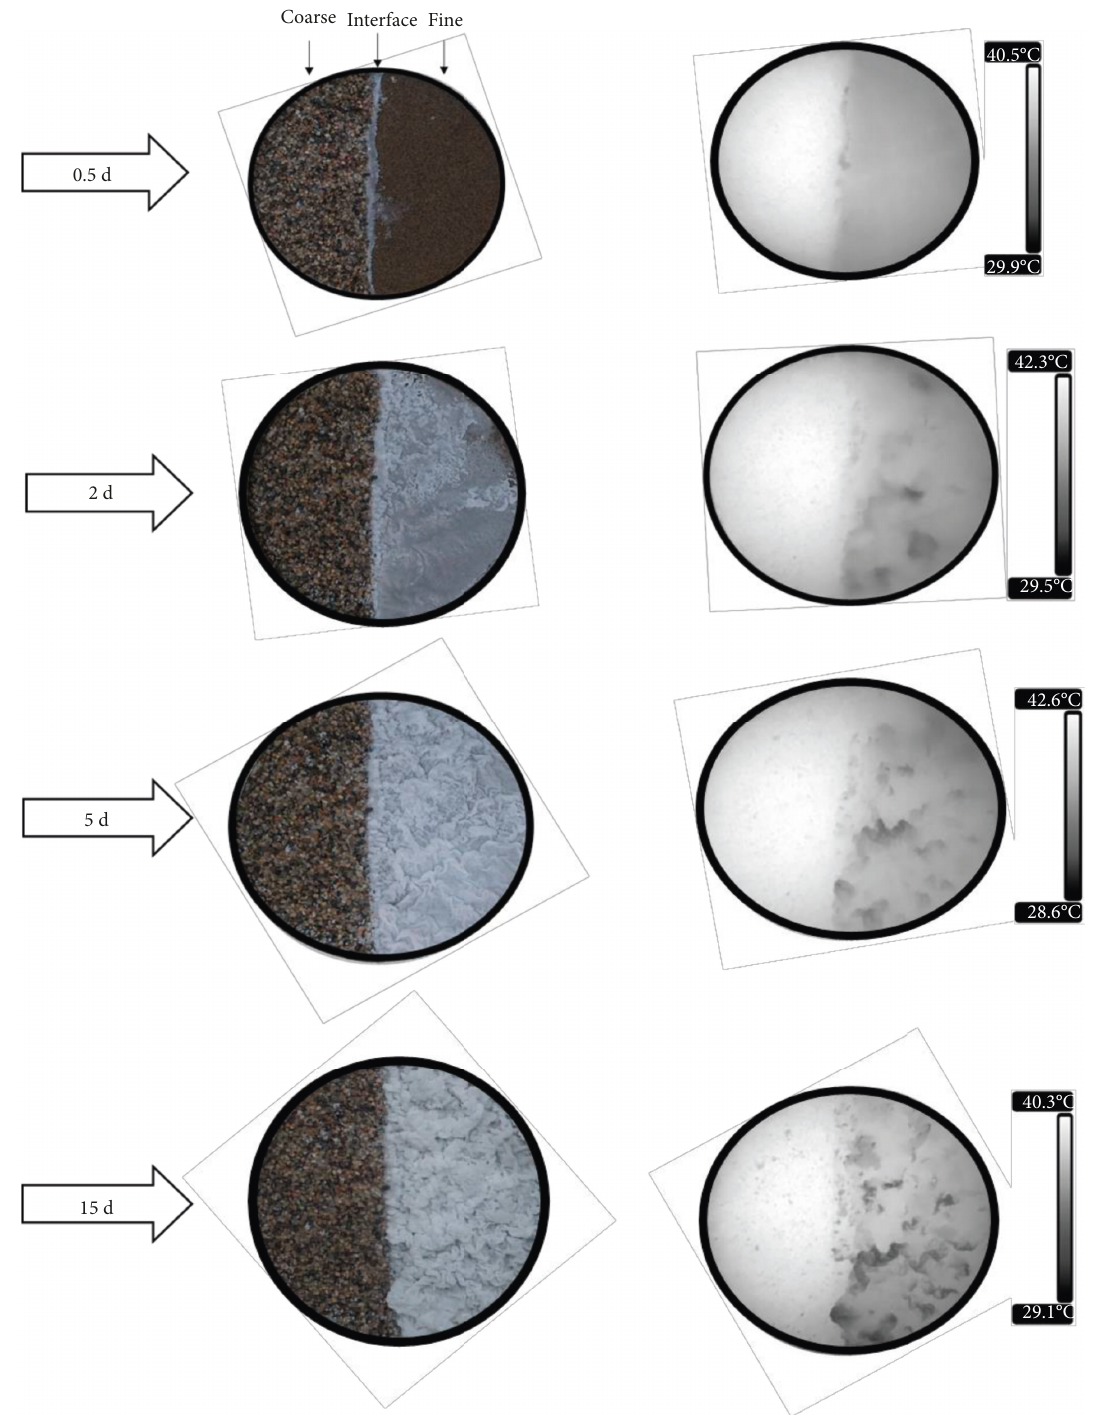
Figure 3: Dynamic variation in salt precipitation (visible light images) and thermal infrared images for heterogeneous sand